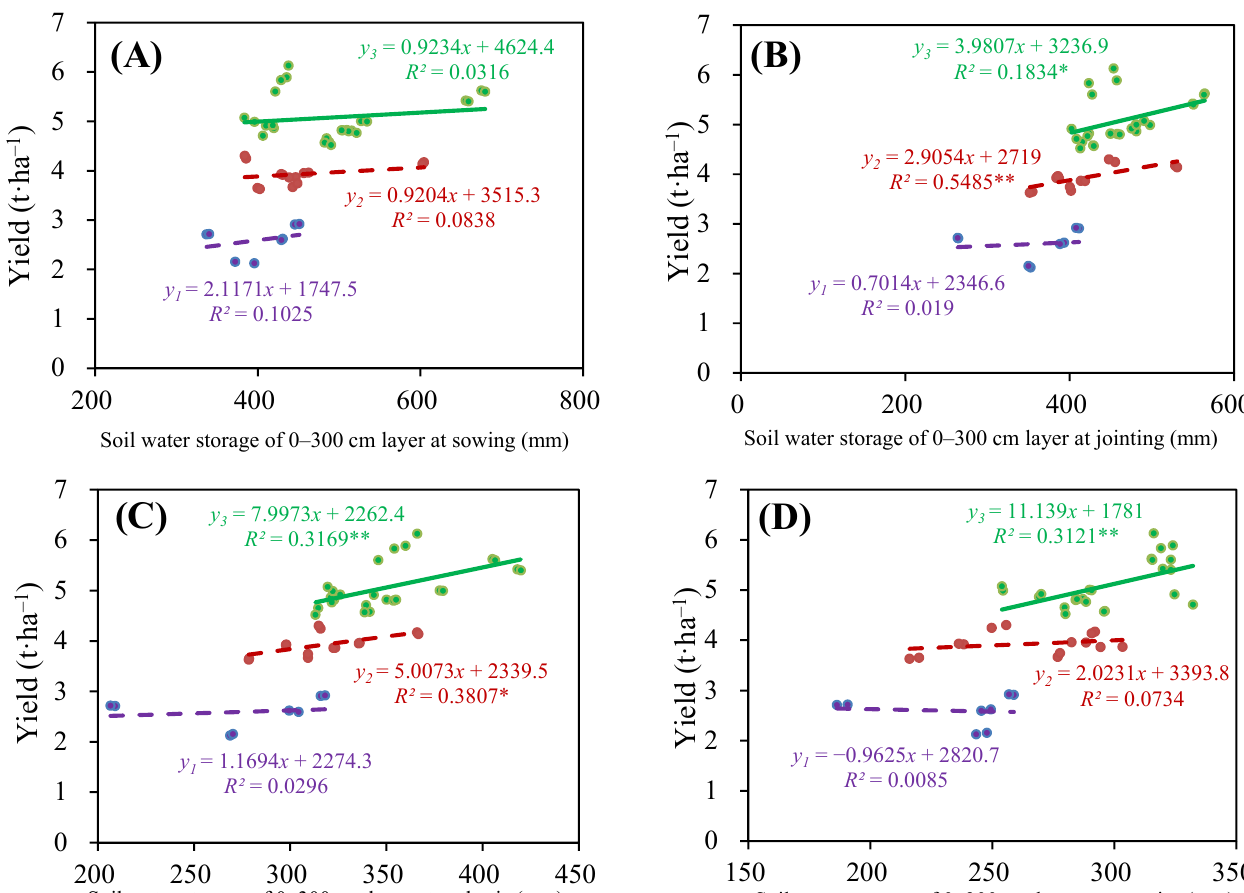
Figure 4. Correlation between soil water storage and sowing stage ( y 2 = FS, furrow sowing; y 3 = WS, wide-space sowing; y 1 = DS, drill sowing); * and ** indicate differences at the 0.05 and 0.01 probability levels, respectively. ( A ) Sowing stage soil water storage ( B ) Jointing stage soil water storage ( C ) Anthesis stages soil water storage ( D ) Maturity stages soil water